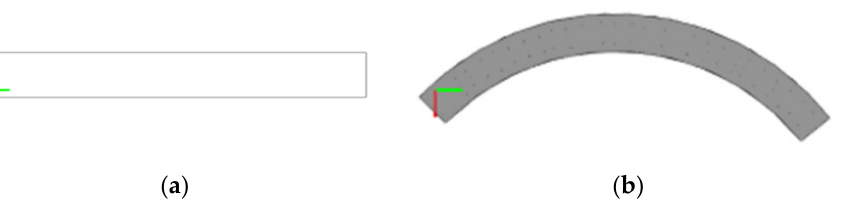
Figure 20. The X-Z projections of the straight ramp and the curved ramp: ( a ) straight ramp and ( b ) curved ramp.